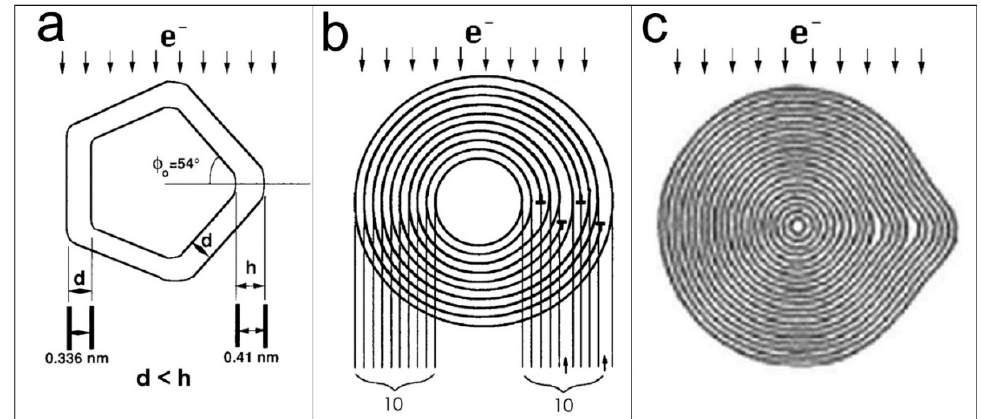
Figure 7. Sketches for three different MWCNT models potentially compatible with the observation of asymmetrically distributed anomalous intergraphene distances along with an even number of graphenes on both sides with respect to the central cavity, for TEM images taken with the electron beam oriented as indicated by “e − ”: ( a ) the polyhedral model proposed by Liu et al. [17,18], copyright permission from Elsevier; ( b ) the combined concentric/scroll model proposed by Amelinckx et al. [19], copyright permission from AAAS; ( c ) a concentric model involving intergraphene distances larger than the equilibrium distance for van der Waals interactions, with subsequent asymmetric relaxation, as calculated by Huang et al. [33].